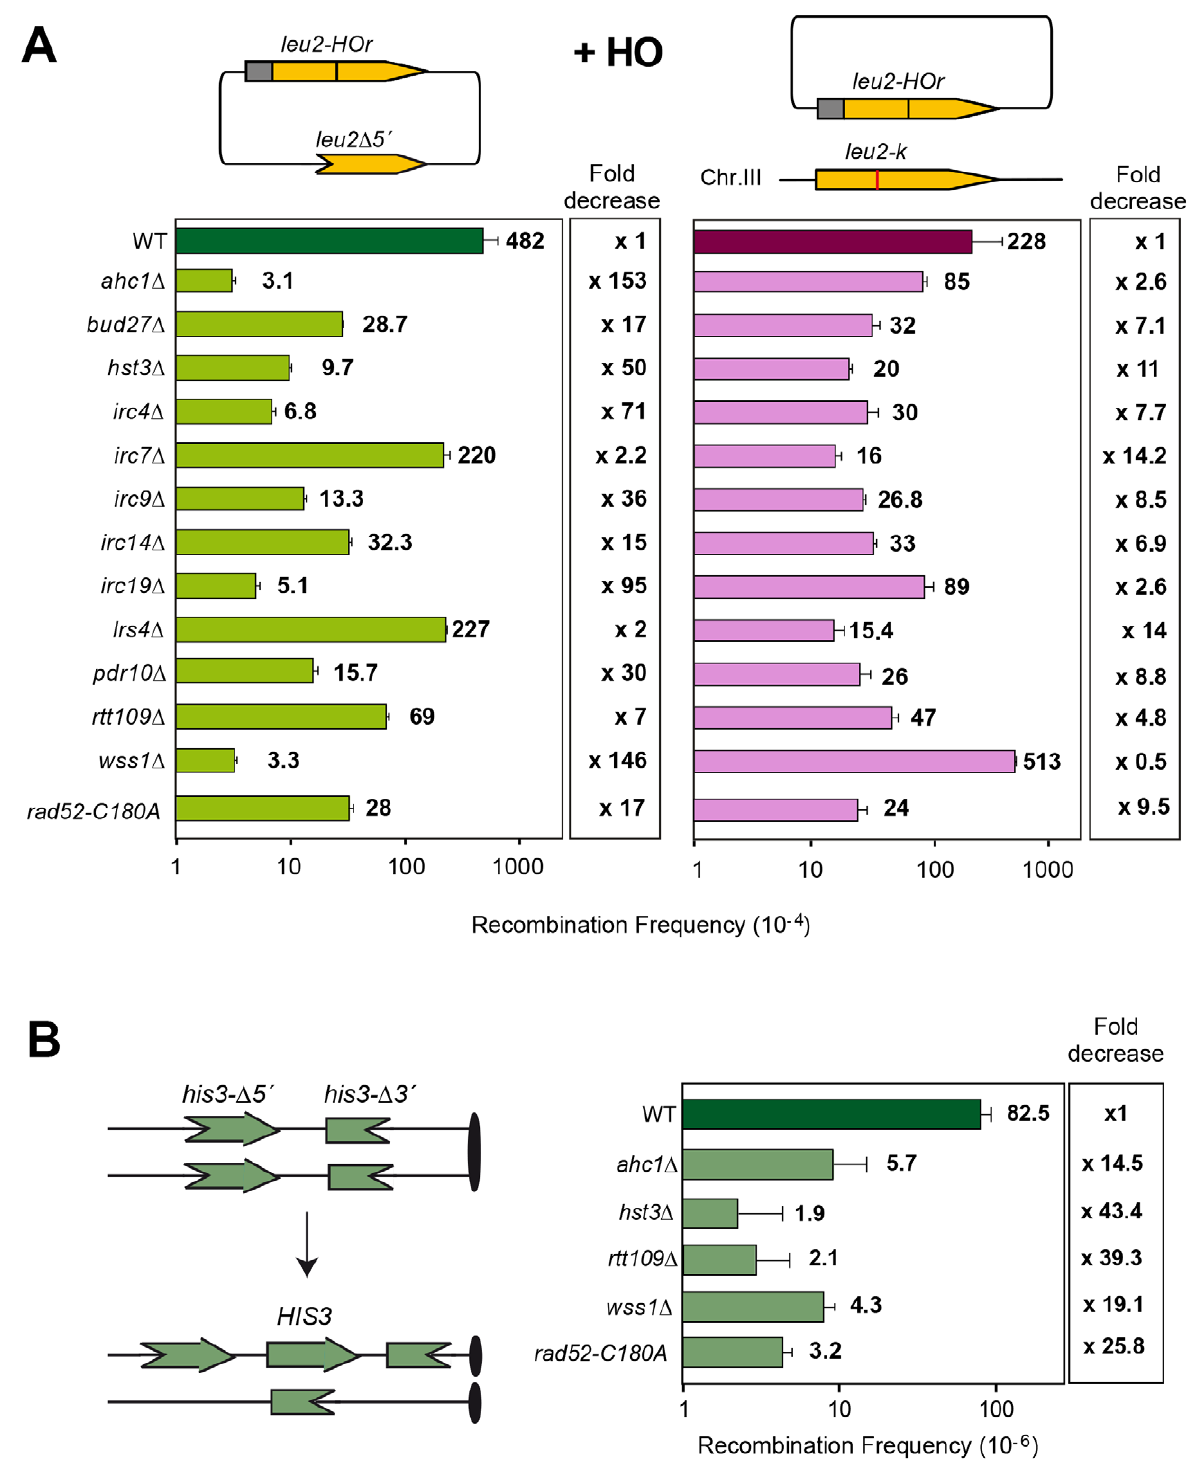
Figure 3. Genetic analysis of recombination in the 13 SCR–defective mutants. (A) Analysis of Leu + intrachromosomal recombination, as an indirect measure of unequal SCR, and plasmid-chromosome recombination events after 5 hr of HO activation in 2% galactose. Values plotted for each genotype are the average and standard deviations of the median of three independent fluctuation tests (each based on 6 samples) performed with three different transformants. (B) Analysis of spontaneous SCR in the chromosomal direct-repeat system his3- D 5 9 ::his3- D 3 9 in WT, hst3 D , ahc1 D , rtt109 D , wss1 D and rad52-C180A strains. A picture of the system and the expected His3 + recombination products are shown.